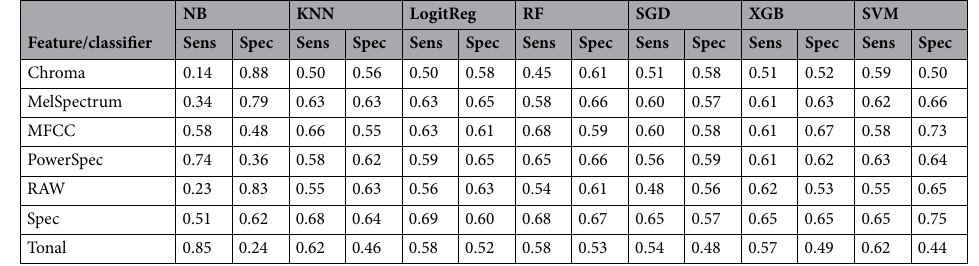
Table 2. Classification sensitivity (Sens) and specificity (Spec) of several shallow machine learning models (training phase).